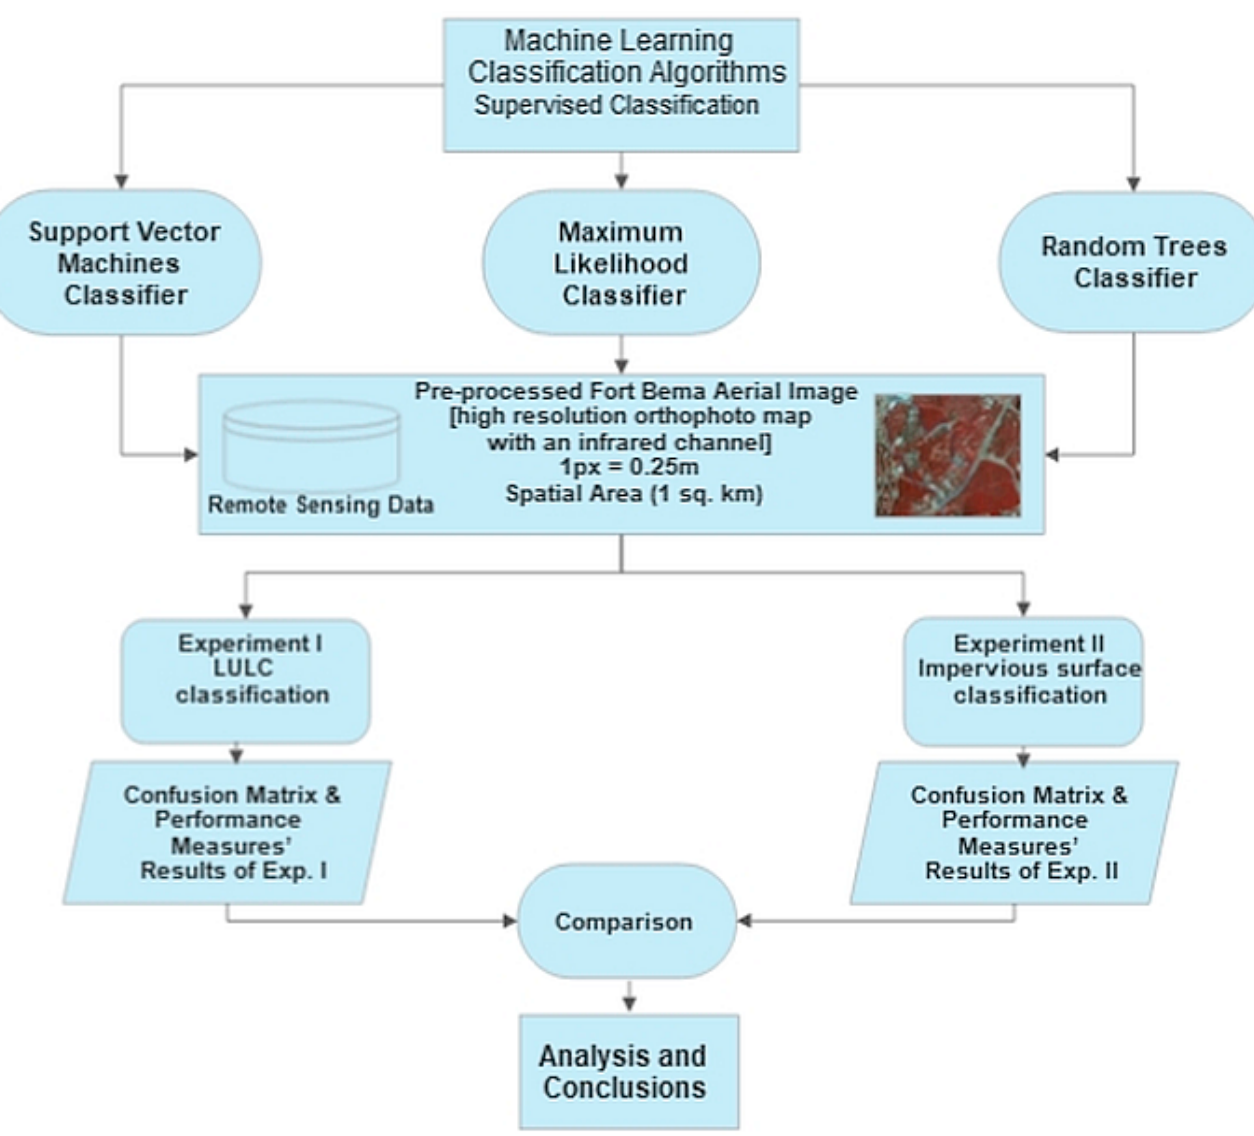
Figure 5. Flowchart of Main Steps in the Research Study (source: own